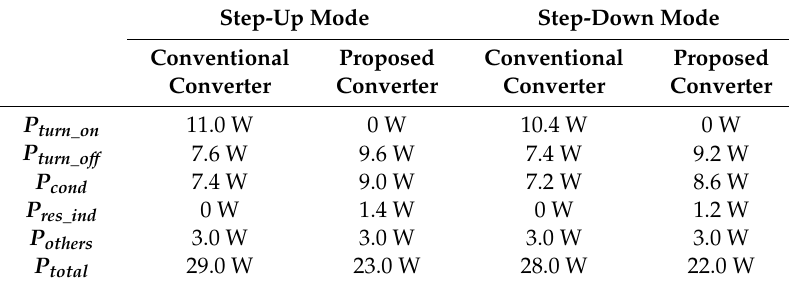
Table 2. Power loss distributions of the